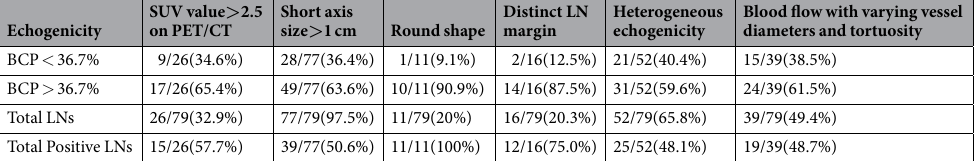
Table 2. Correlation among EBUS elastography types, B-mode features and vascular patterns of LNs. Data are shown as the number of LNs/total number of LNs and percentage (%), BCP, blue color proportion.